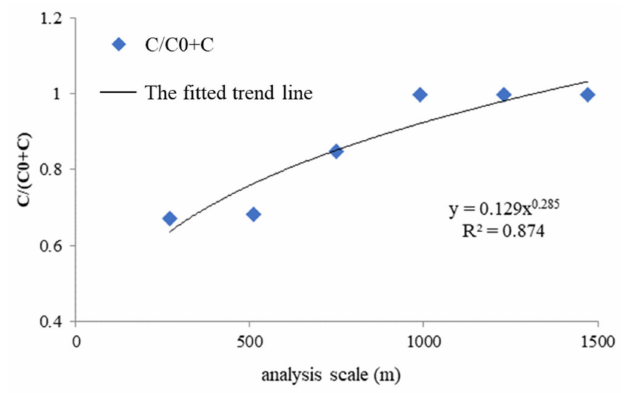
Figure 3. Trends of spatial heterogeneity for landscape fragmentation at di ff erent scales.